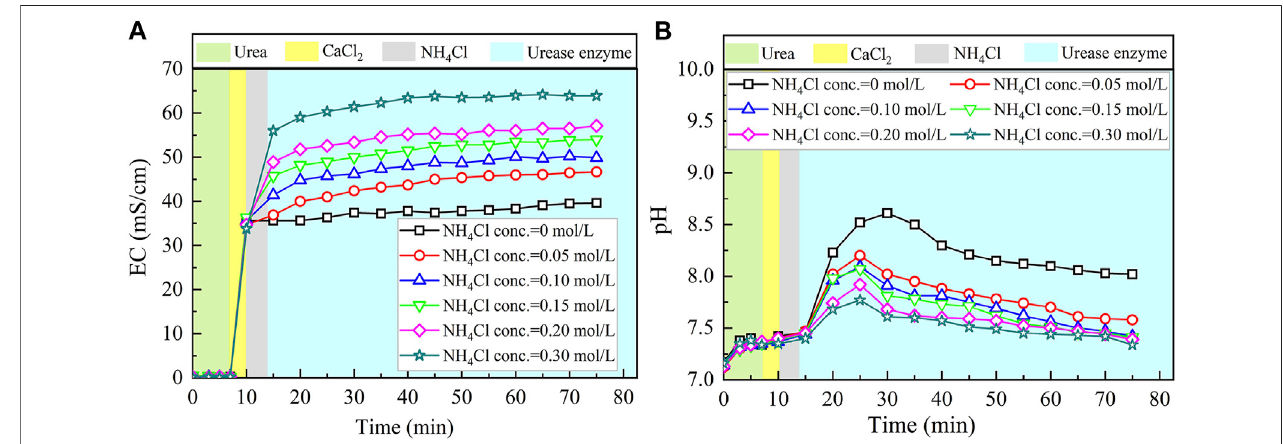
FIGURE 6 | Temporal relations of EC and pH when subjected to the effect of NH 4 Cl addition: (A) EC and (B) pH.